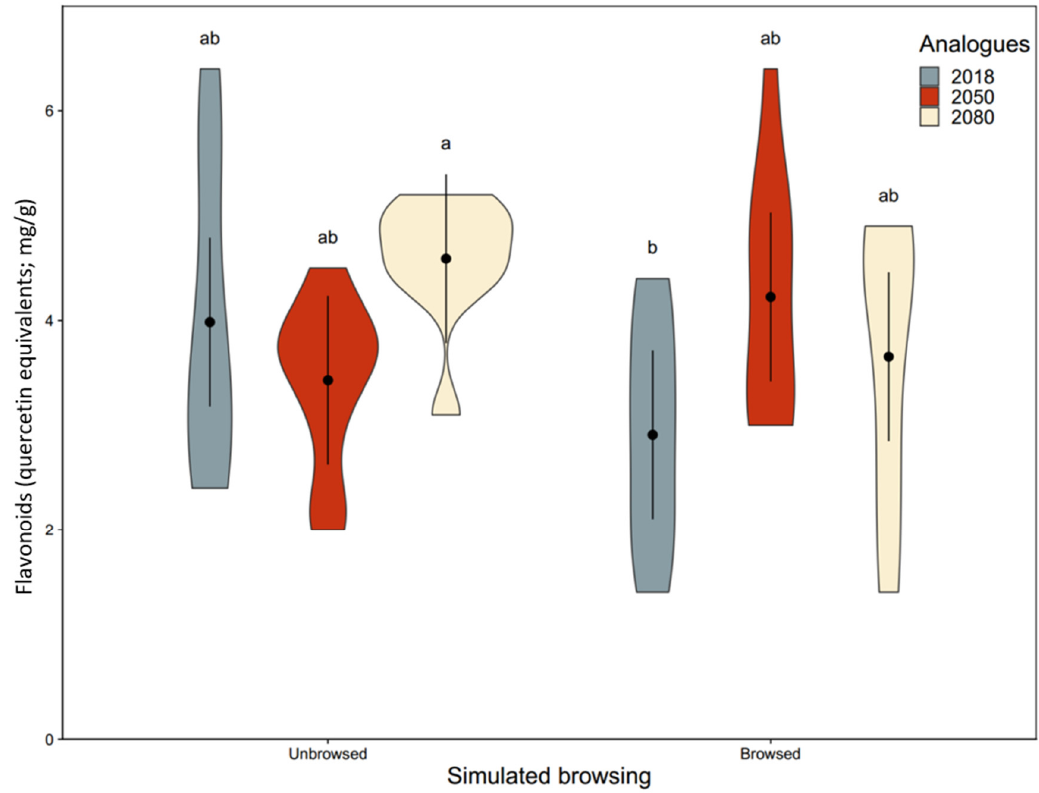
Figure A2. Simulated winter browsing effect on flavonoid concentration in three climate analogues black cherry ( Prunus serotina Ehrh.) seedlings. Seedling dry mass ( 𝑥̅ ± 95%CI of model estimates) was measured after ten weeks of growth in a greenhouse. Three different climate analogues were used (2018: analogue to the current climate at Réserve faunique de Portneuf (Québec, QC, Canada); 2050: analogue to the climate predicted for mid-century; 2080: analogue to the climate predicted for the end of the century). The analysis was performed using a linear mixed model with a random effect of blocks ( n = 5). Different letters indicate a posteriori least square mean differences performed on climate analogue and browsing treatment ( α = 0.05). Shapes represent the distribution of the data.